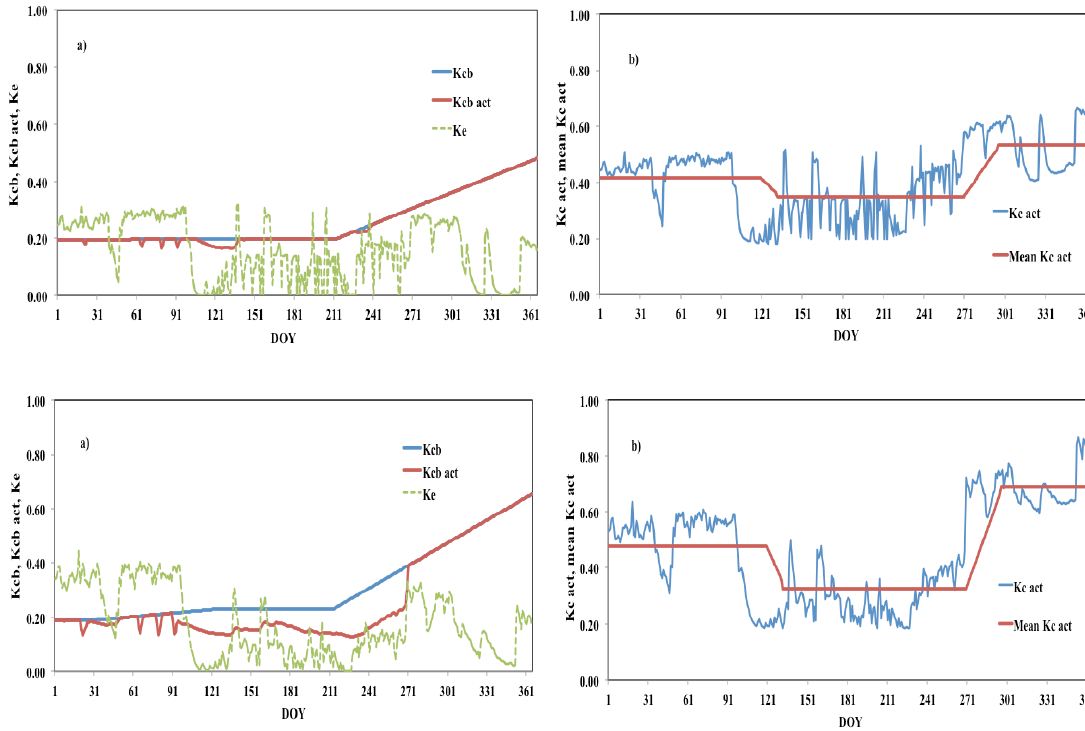
Figure 7. Daily crop coefficients derived from the SIMDualKc model in the year 2013 for 70DI (upper panel) and 50DI (lower panel); ( a ) basal crop coefficient adjusted for climate conditions and canopy density (K cb ), basal crop coefficient (K cb act ) adjusted for water stress conditions, soil evaporation coefficient (K e ); ( b ) actual (K c act ) and mean crop coefficient for the different growth stages.